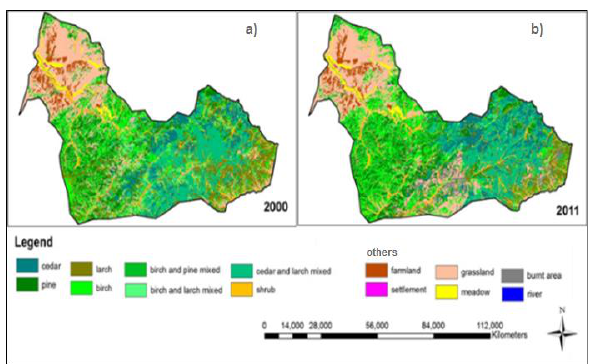
Figure 5. Classified for the forest types using satellite imagery